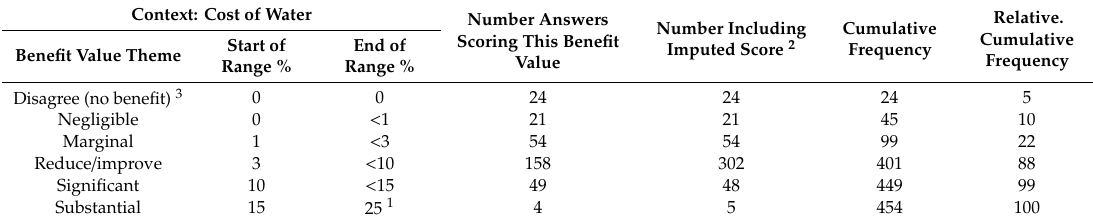
Table 8. Qualitative-to-quantitative transformation of benefit value—cost of